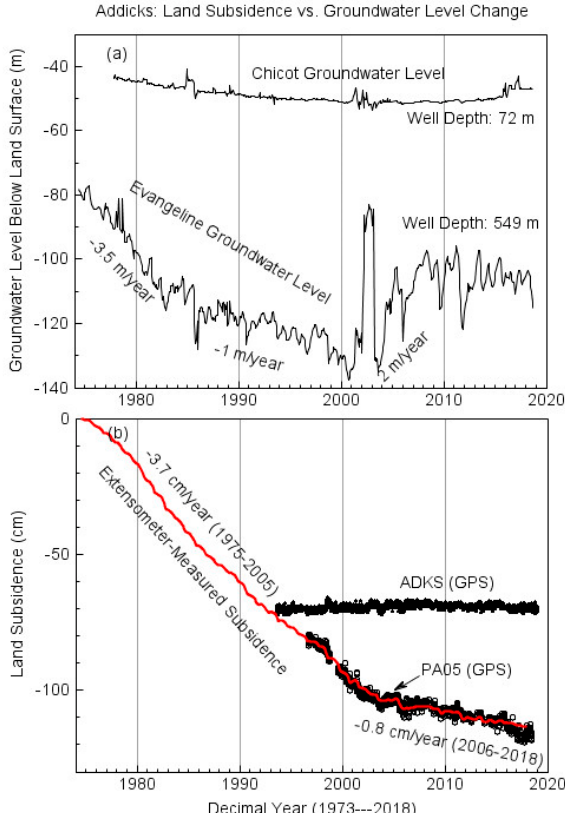
Figure 14. (a) The history of groundwater-level altitudes (1974–2018) in the Chicot and Evangeline aquifers measured at the Addicks extensometer site (Figure 13); (b) the history of the land subsidence recorded by the extensometer (1974–2018) and GPS antenna PA05 (1996–2018). The GPS antenna ADKS is mounted on the top of the inner pole of the extensometer (see Figure 5).